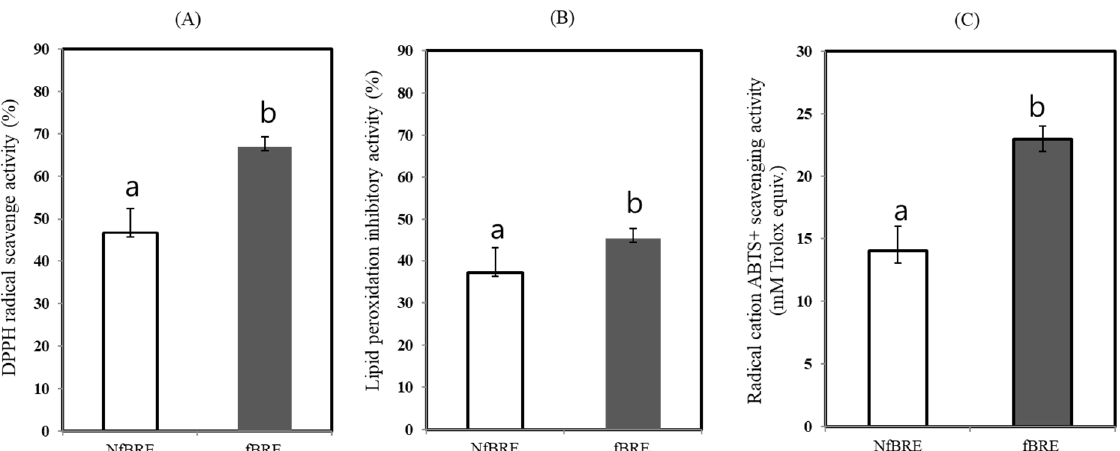
Figure 4. Changes in antioxidant activity of the fermented black raspberry extract by Pediococcus acidilactici M76. ( A ) DPPH radical scavenge activity (%). ( B ) Lipid peroxidation inhibitory activity (%). ( C ) Radical cation ABTS+ scavenging activity. NfBRE: (□), fBRE: ( ■ ). a,b Means with different letters are significantly different ( p < 0.05).